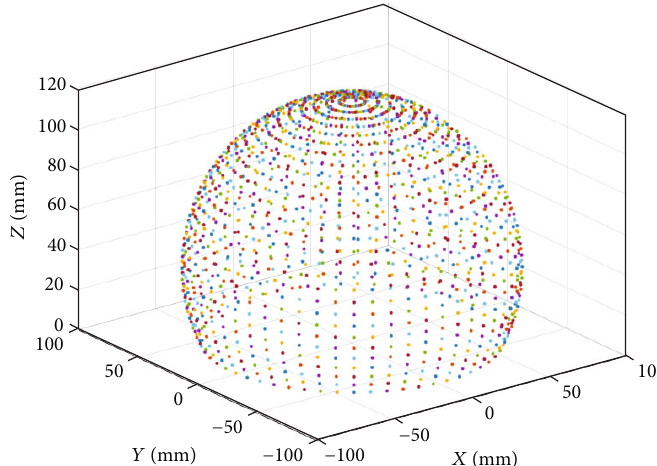
Figure 8: One-segment catheter workspace in 3D.